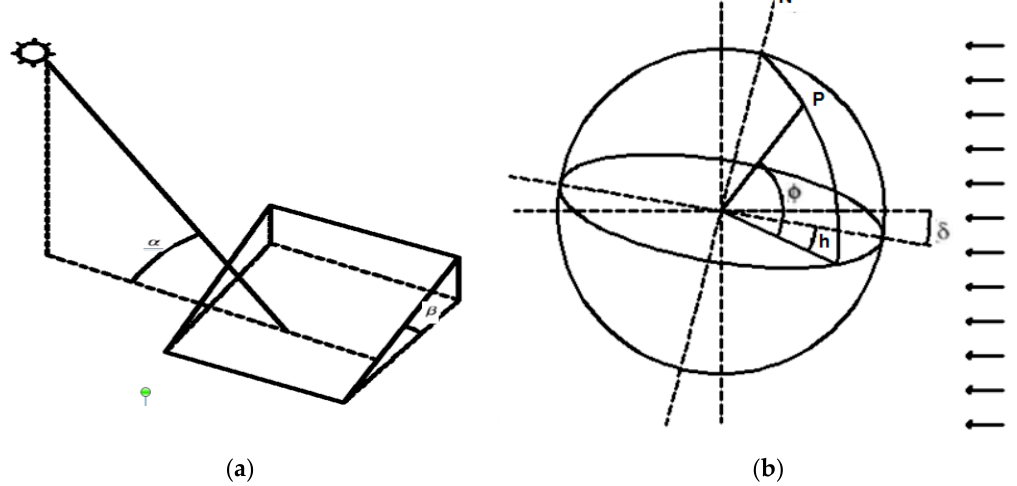
Figure 2. Major solar angles: ( a ) Tilt angle ( β ) and Altitude angle ( α ) ( b )Declination angle ( δ ), Latitude angle ( ∅ ), and Hour angle (h).